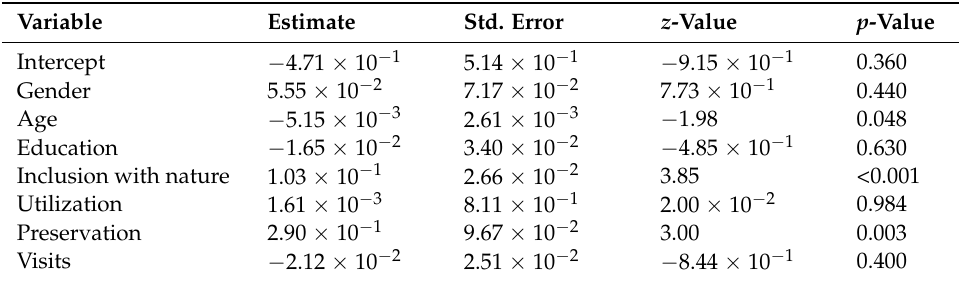
Table A2. Beta-regression of bark-beetle-affected forest portion, with gender, age, and education level of respondents, inclusion with nature, utilization, preservation, and prior visits as predictor variables ( n = 1008). Because a beta-regression is applicable only when the dependent values are ∗ ( n obs − 1 )+ 0.5 between 0 and 1, the standardization y suggested by Smithson and Verkuilen [74] was n obs applied. Boldface indicates